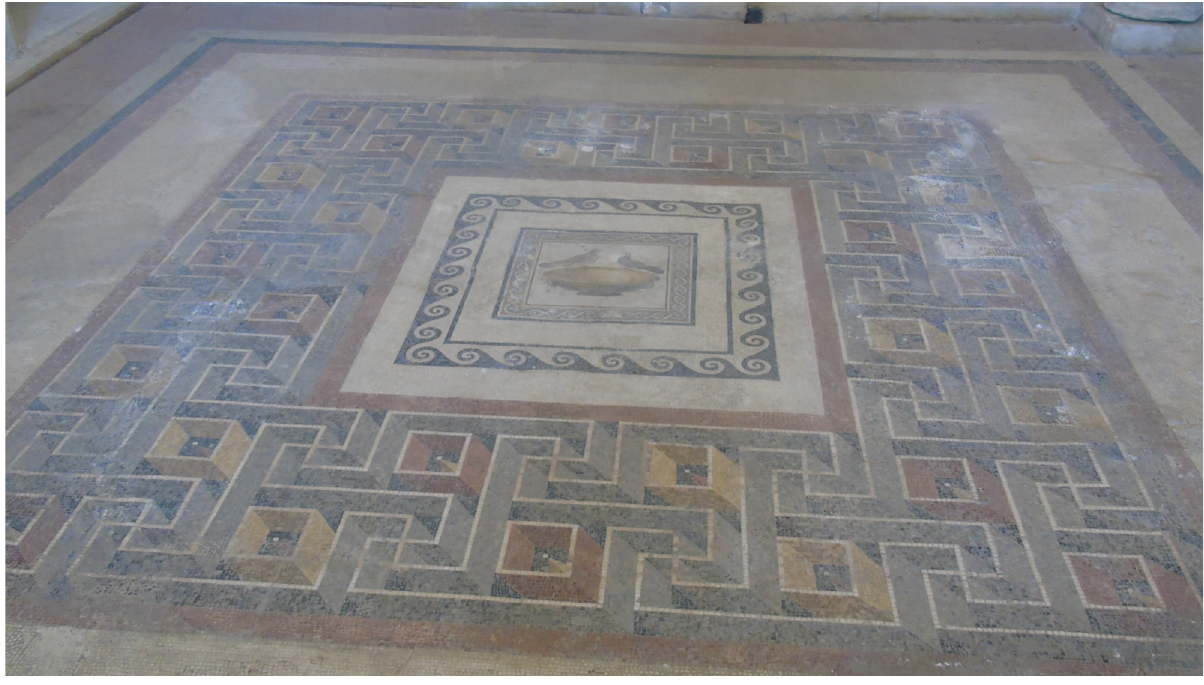
Figure 4: Peristyle mosaic, Domus Romana (Photo: author, courtesy of Heritage